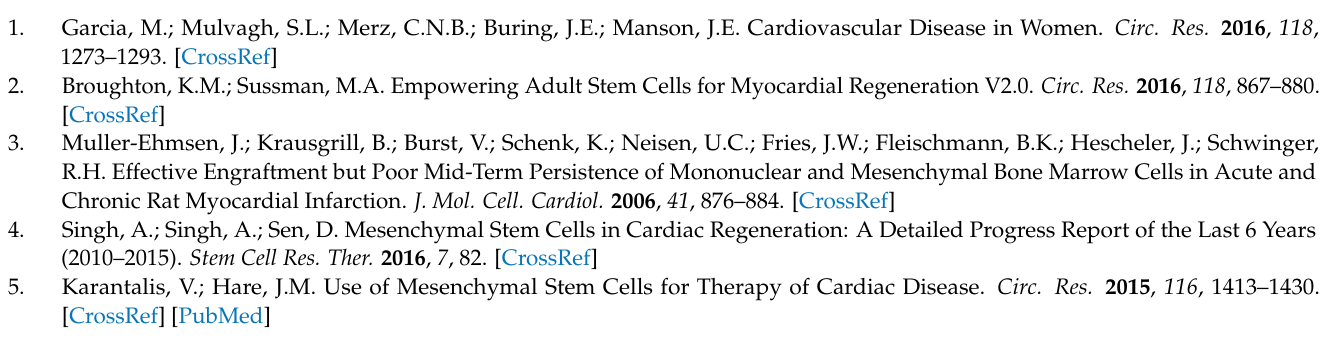
Table S1: Information on Major Resources Used, Table S2: Primers used for qRT-PCR assay, Table S3: Funrich Analysis of Over-represented Proteins of the Cellular Component in MSCs following estradiol treatment, Table S4: Funrich Analysis of Over-represented Proteins of the Molecular Function in MSCs following estradiol treatment, Table S5: Funrich Analysis of Over-represented Proteins of the Biological Process in MSCs following estradiol